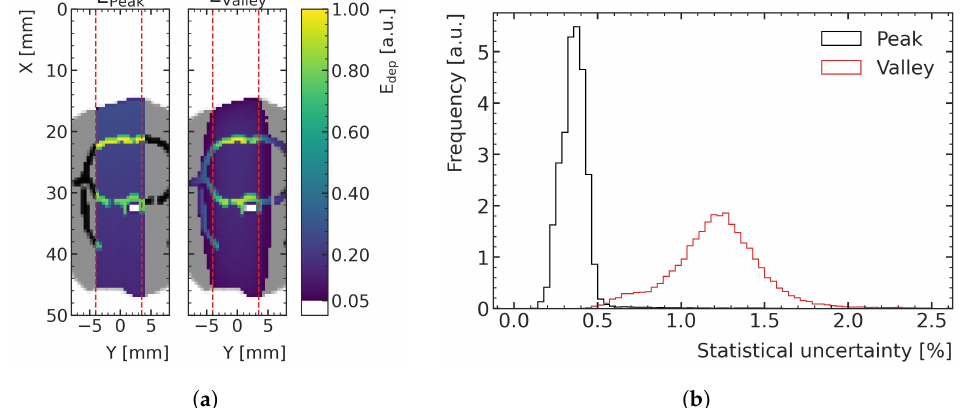
Figure 5. ( a ) Two-dimensional slice of the MC-simulated energy deposition in the peak (left) and valley (right), respectively, at the center of the prediction volume for an exemplary low-noise training sample (rat number 15), normalized to their respective maximums. Air is shown in white, tissue (water) in gray and bone in black. ( b ) Histograms of the voxelwise statistical uncertainties (quantified with the standard error) of the peak and valley energy deposition MC simulations of the three low-noise treatment test data